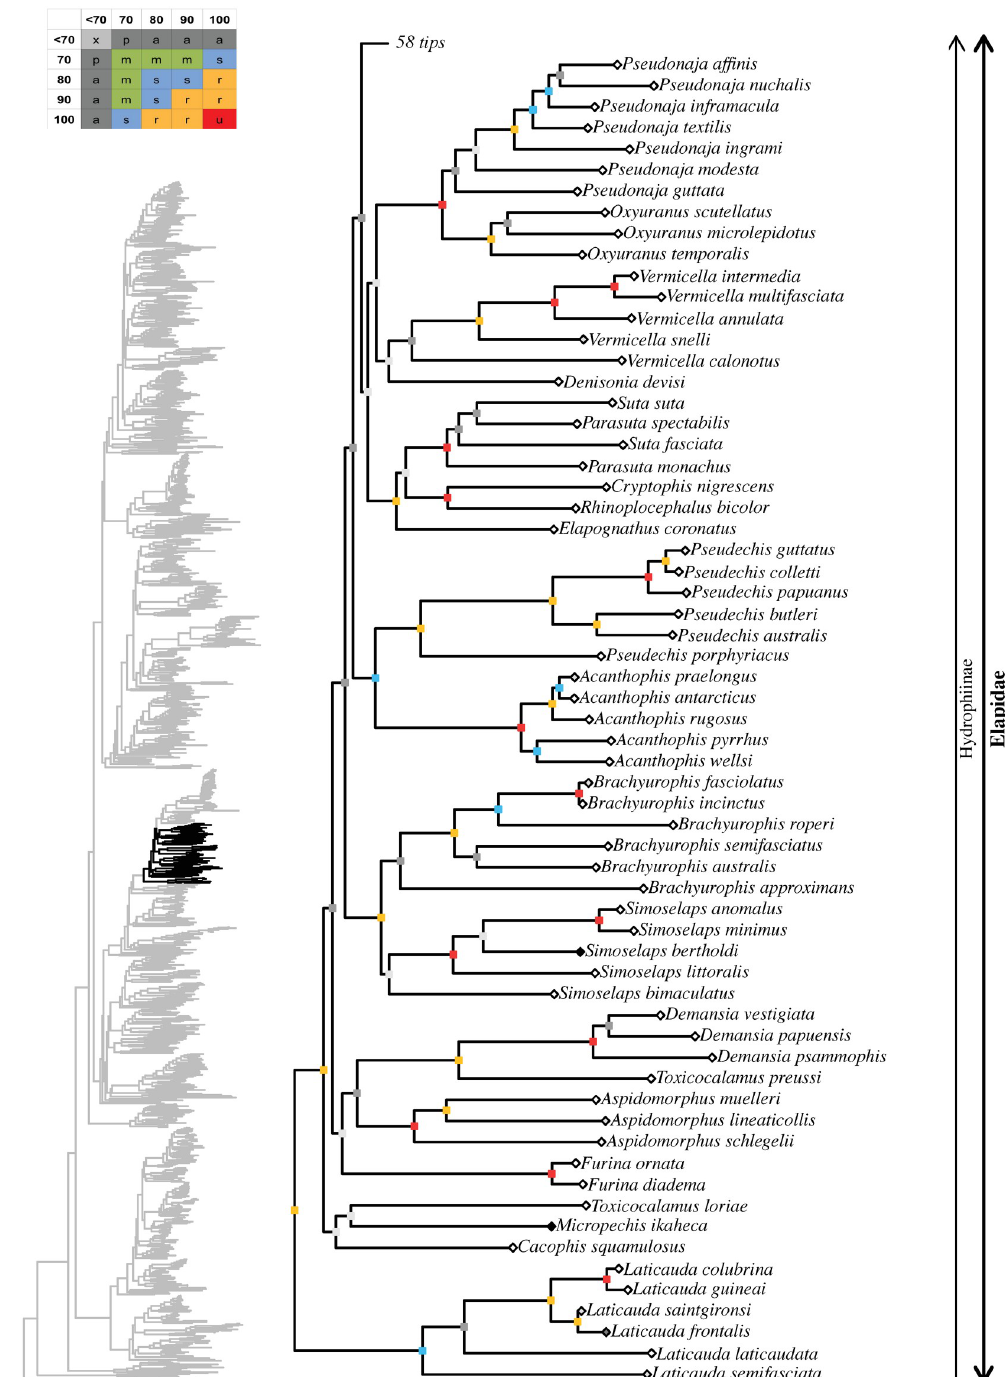
Fig 13. Maximum likelihood species-level phylogeny of Colubroides (continued). Family Elapidae (continued).